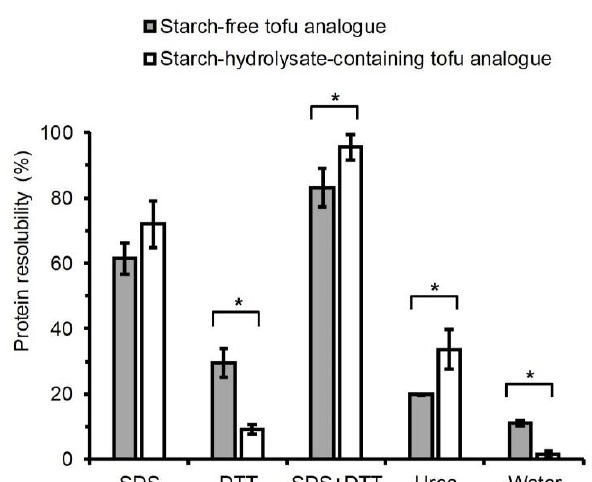
Figure 7. Resolubility of proteins from starch-free and starch-hydrolysate-containing tofu analogues in Milli-Q water and in 2% sodium dodecyl sulfate (SDS) solution, 10 mM Dithiothreitol (DTT) solution, 2% SDS + 10 mM DTT solution and 8 M urea solution. Each result shows the average of three measurements with the standard deviation. * indicates significant difference between two types of tofu analogues ( p < 0.05).